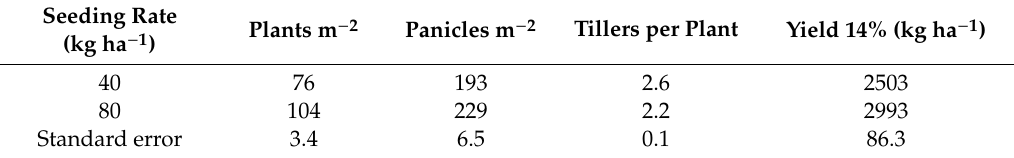
Table 6. E ff ect of seeding rate on rice yield components in 2018.